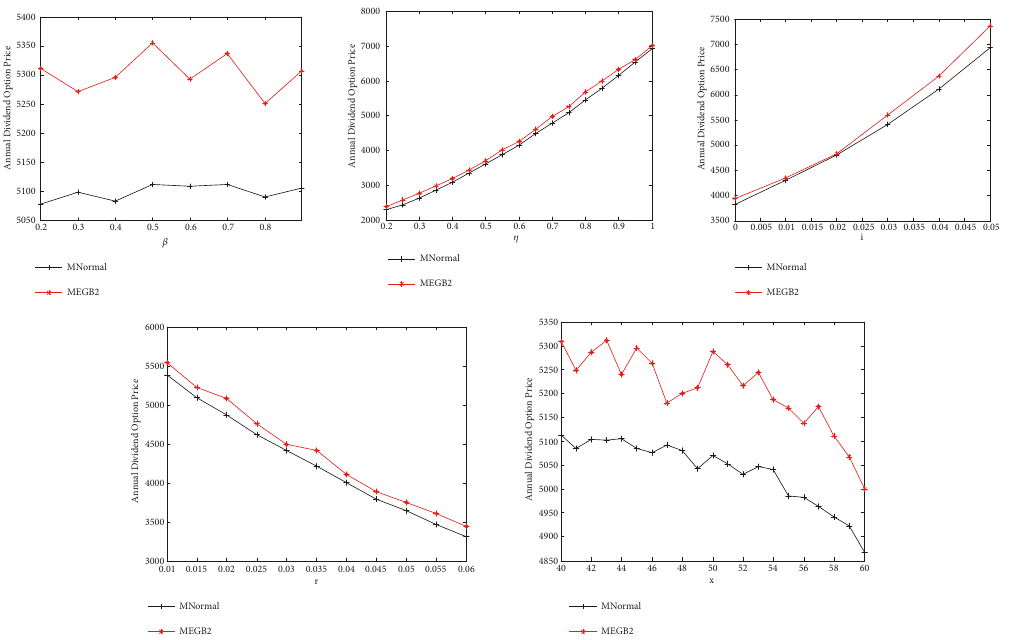
Figure 5: Parameter sensitivity analysis of annual dividend option between MEGB2 and Multivariate Normal asset